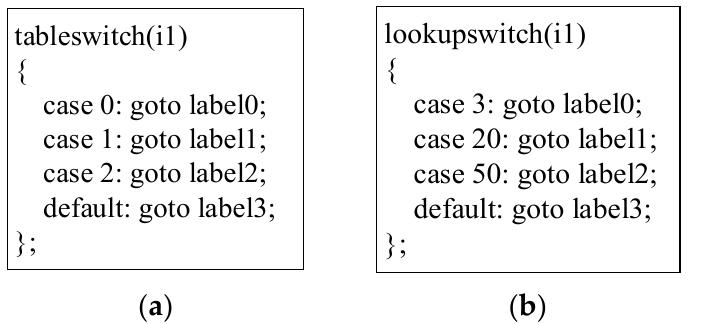
Figure 4. Examples of two switch Jimple statements: ( a ) TableSwitchStmt; ( b ) LookupSwitchStmt.